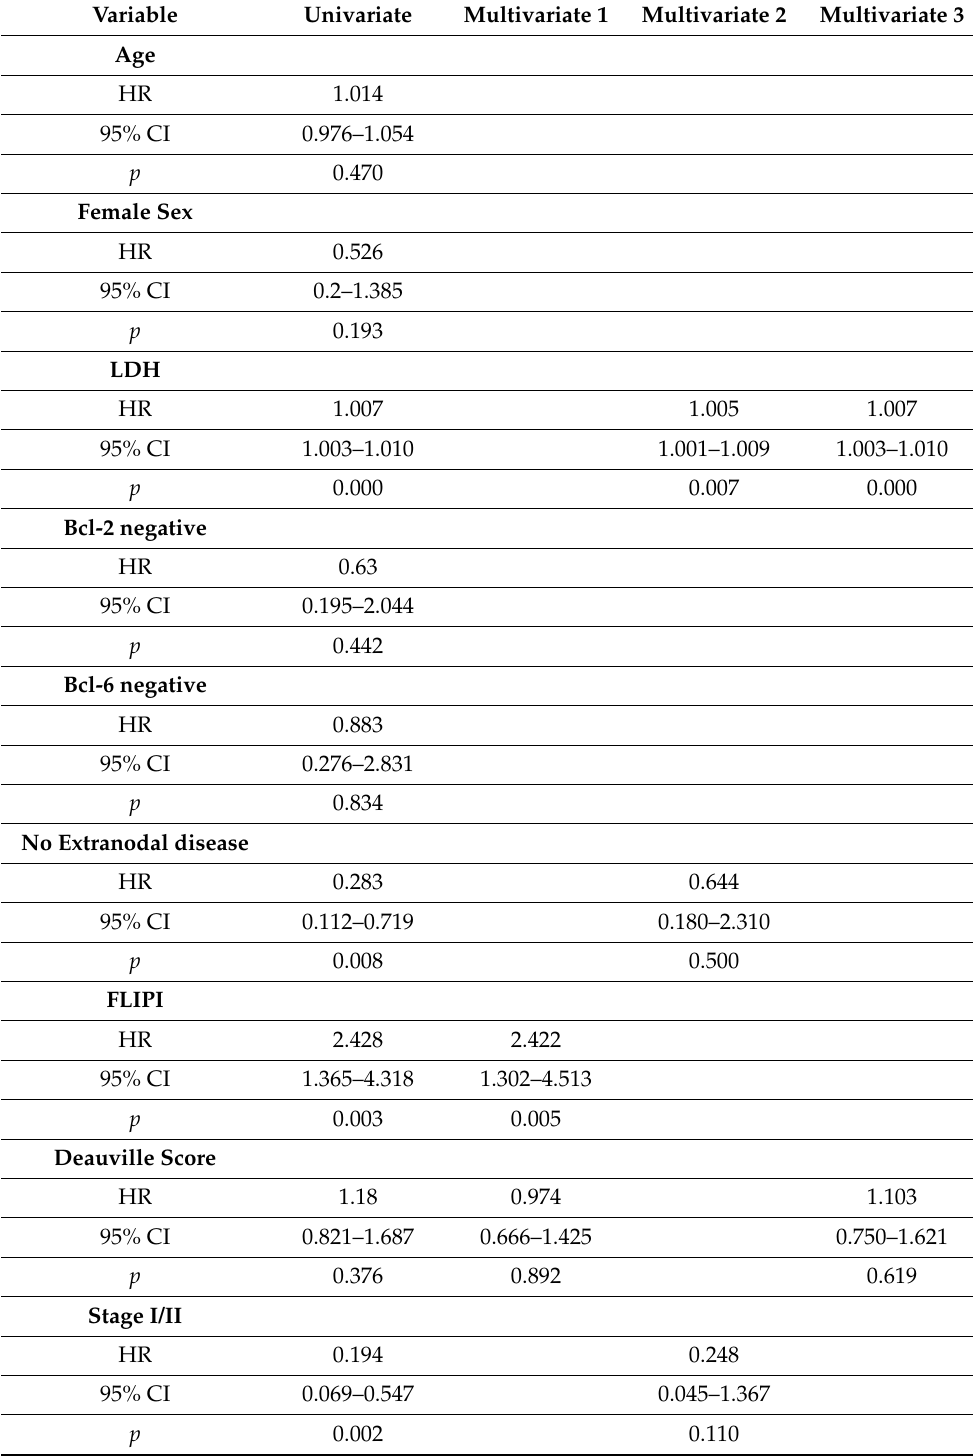
Table 10. Univariate and multivariate influences on